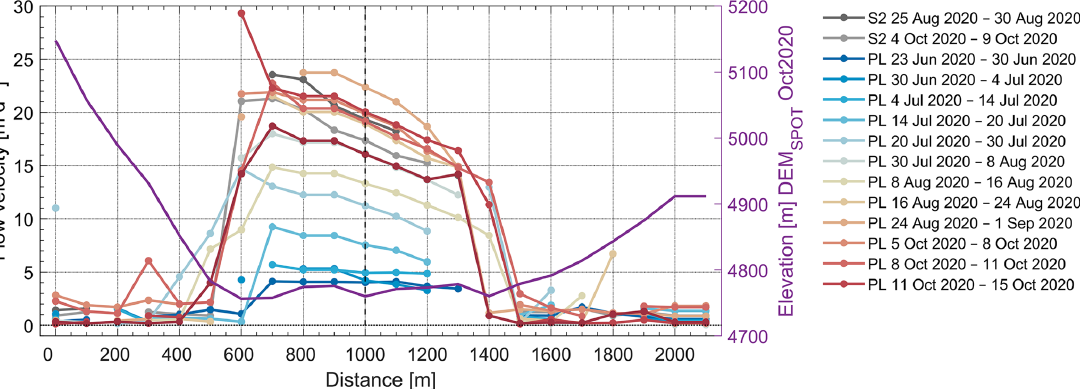
Figure 9. South-west to north-east cross-profile surface flow velocities for South Chongtar Glacier derived from Planet and comparison with Sentinel-2. The vertical dashed line indicates the location of the centreline. See Fig. 1 for location of the